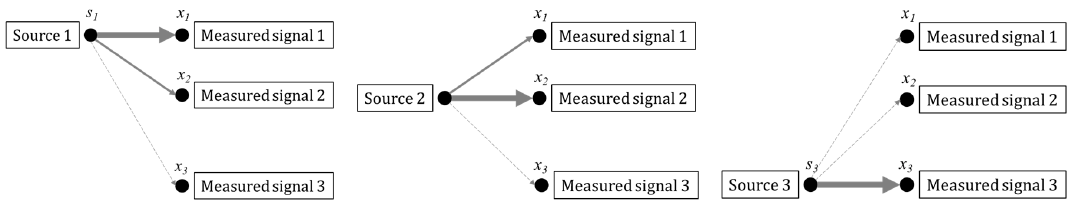
Figure 12. Strategy of labeling the sources.